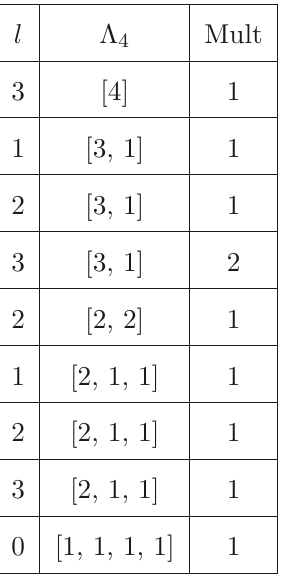
Table 4 . Results for n = 4 fields and k = 3 derivatives.